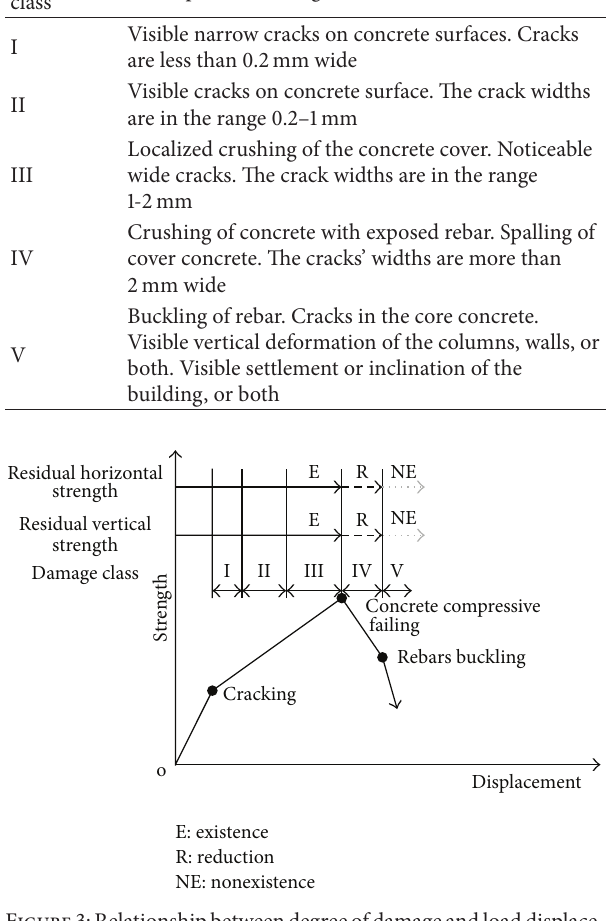
Figure3:Relationshipbetweendegreeofdamageandloaddisplace- ment of the shear member